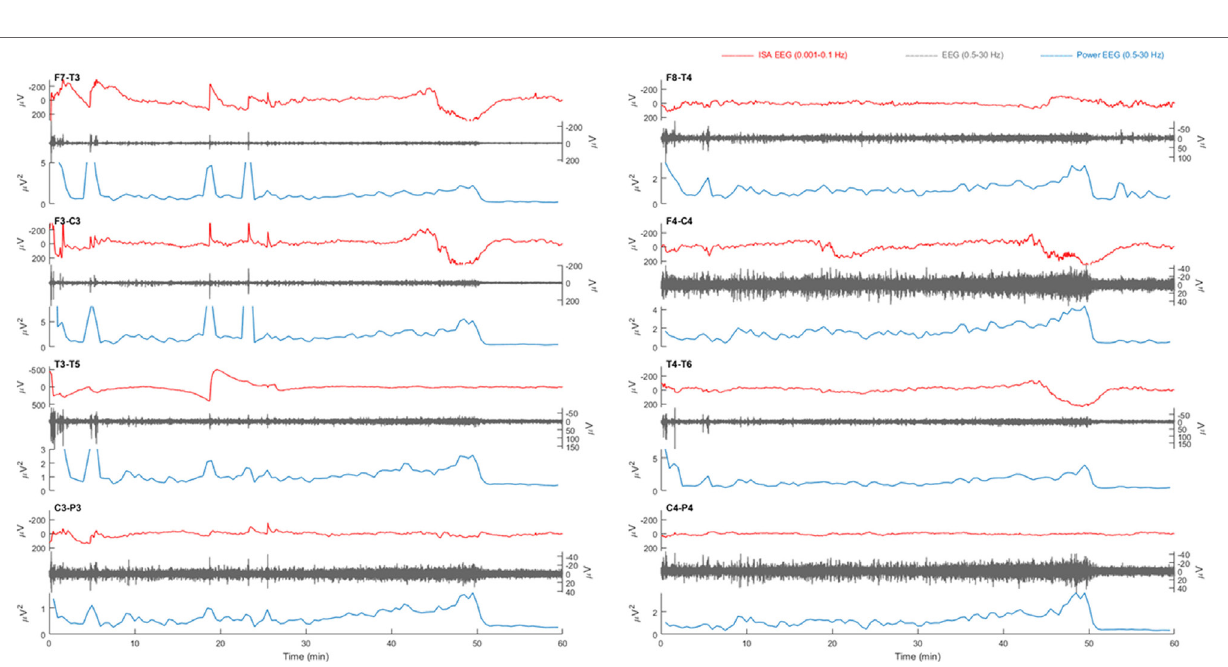
FigUre 2 | Typical example of a 1 h electroencephalography (EEG) overview from patient 8 with traumatic brain injury. Source derivations for four electrodes (F7, F3, P3, and T5) of the left hemisphere and four electrodes (F8, F4, P4, and T6) of the right hemisphere are displayed. At 20 min, in the infraslow frequency (ISA) band (0.001–0.1 Hz, red), a slow potential change (SPC) is present on all electrode positions except F7 and T6. The SPC is accompanied by a depression of spontaneous activity (0.5–30 Hz, gray), which is clearly visible in the power of this frequency band (blue). The suppression is not focal, as expected in cortical spreading depolarization (CSD), but occurs on all positions